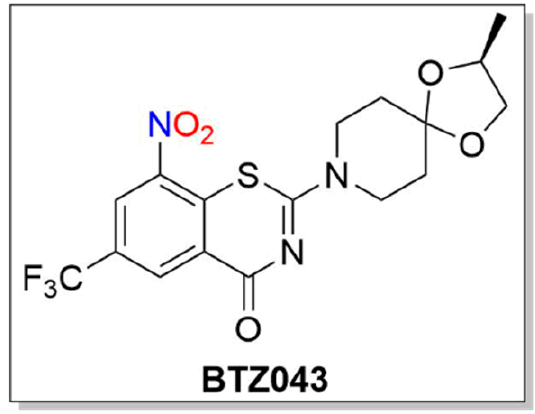
Figure 8. Structure of BTZ043.